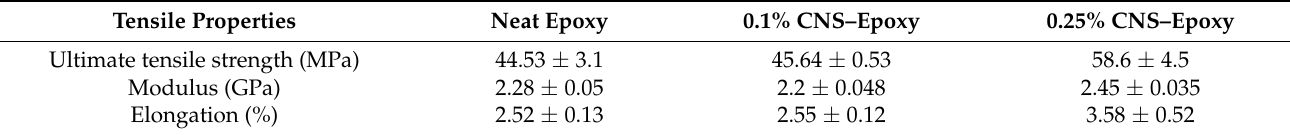
Table 14. Tensile properties of CNS–epoxy composites [2].